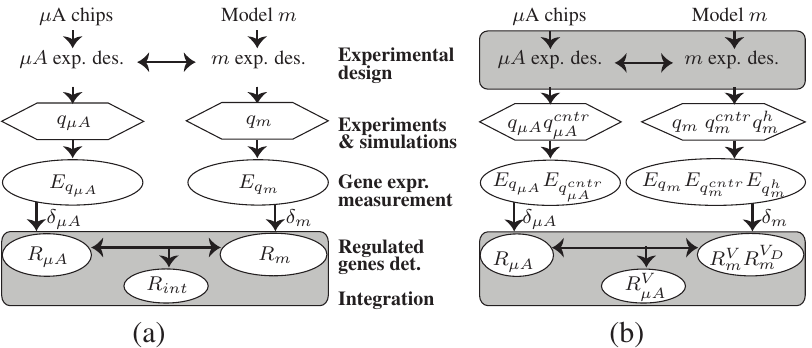
Figure 5: The modules interested by the application for removing the in silico regulated genes (a) and by the application for removing the genes regulated by non controlled variables